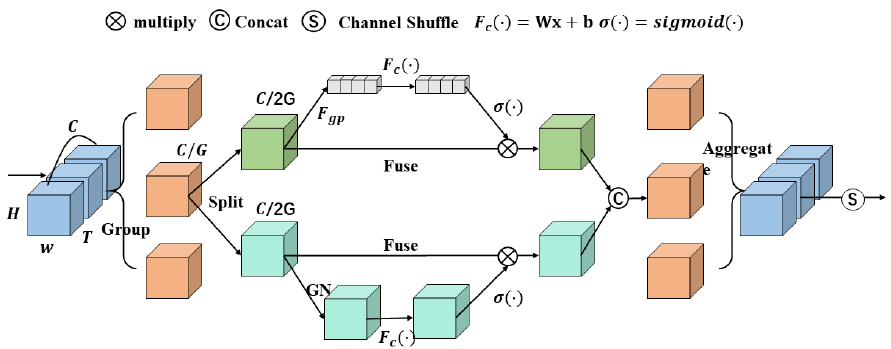
Figure 9. An overview of the proposed SA module. The C channels are divided into G groups and each group has C/G channels. “Split” means “channel split”. It adopts “channel split” to process the sub-features of each group in parallel. Each group is divided into two sub-features and each sub-feature has C/2G channels. F gp means to use global average pooling (GAP) to generate channel-wise statistics; then, F c uses a pair of parameters to scale and shift the channel vector. σ means to use the sigmoid activation function to create a compact feature to guide more precise and adaptive channel selection. Group norm (GN) is adopted to generate spatial-wise statistics. “Fuse” means keep the tensor unchanged, directly as input. The two branches are then concatenated. After that, all sub-features are aggregated, and finally, SA utilizes a “channel shuffle” operator to enable information communication between different